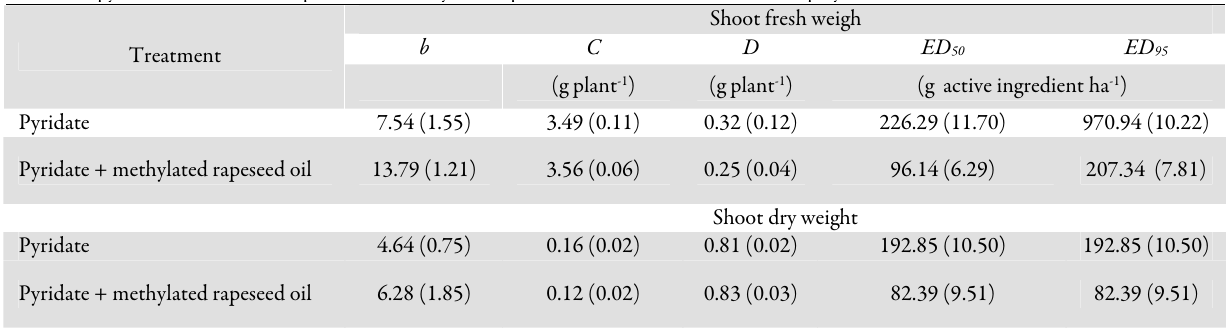
Tab. 1. Estimated regression parameters for the dose-response curves (in Fig. 1) of common lambsquarters ( Chenopodium album L.) treated with herbicide pyridate alone and in the presence of methylated rapeseed oil at 0.5% concentration of spray volume